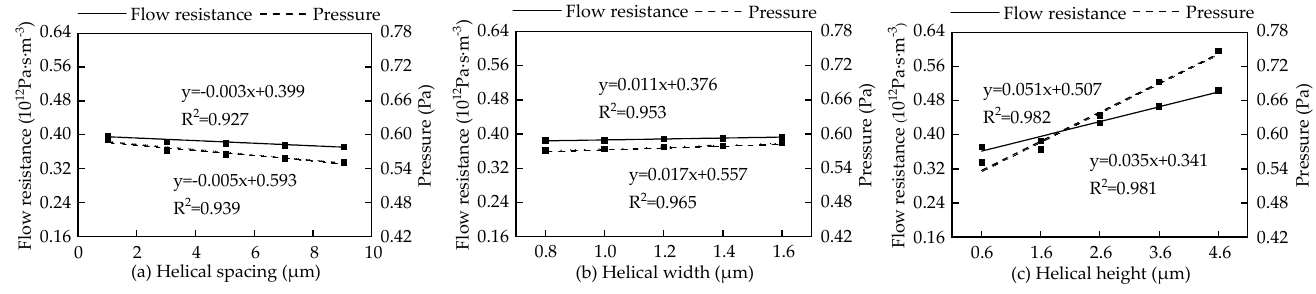
Figure 7. Flow resistance trends of the helical thickening structure.